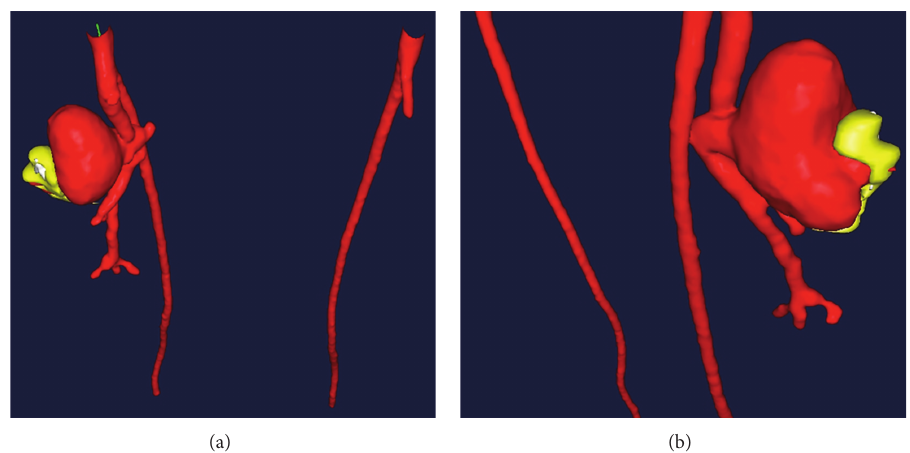
Figure 2: 3D reconstruction of left profunda femoris artery pseudoaneurysm. (a) Posterior-superior view, (b) left anterolateral